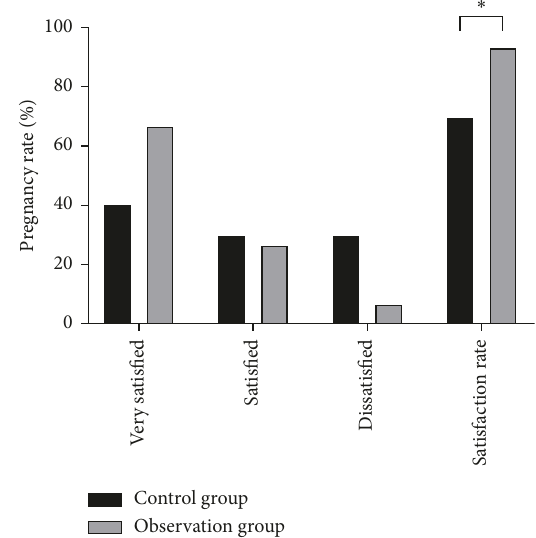
Figure 9: Comparison of the nursing satisfaction rate between the two groups. Note: compared with the control group, P 0 . 05. ∗ <